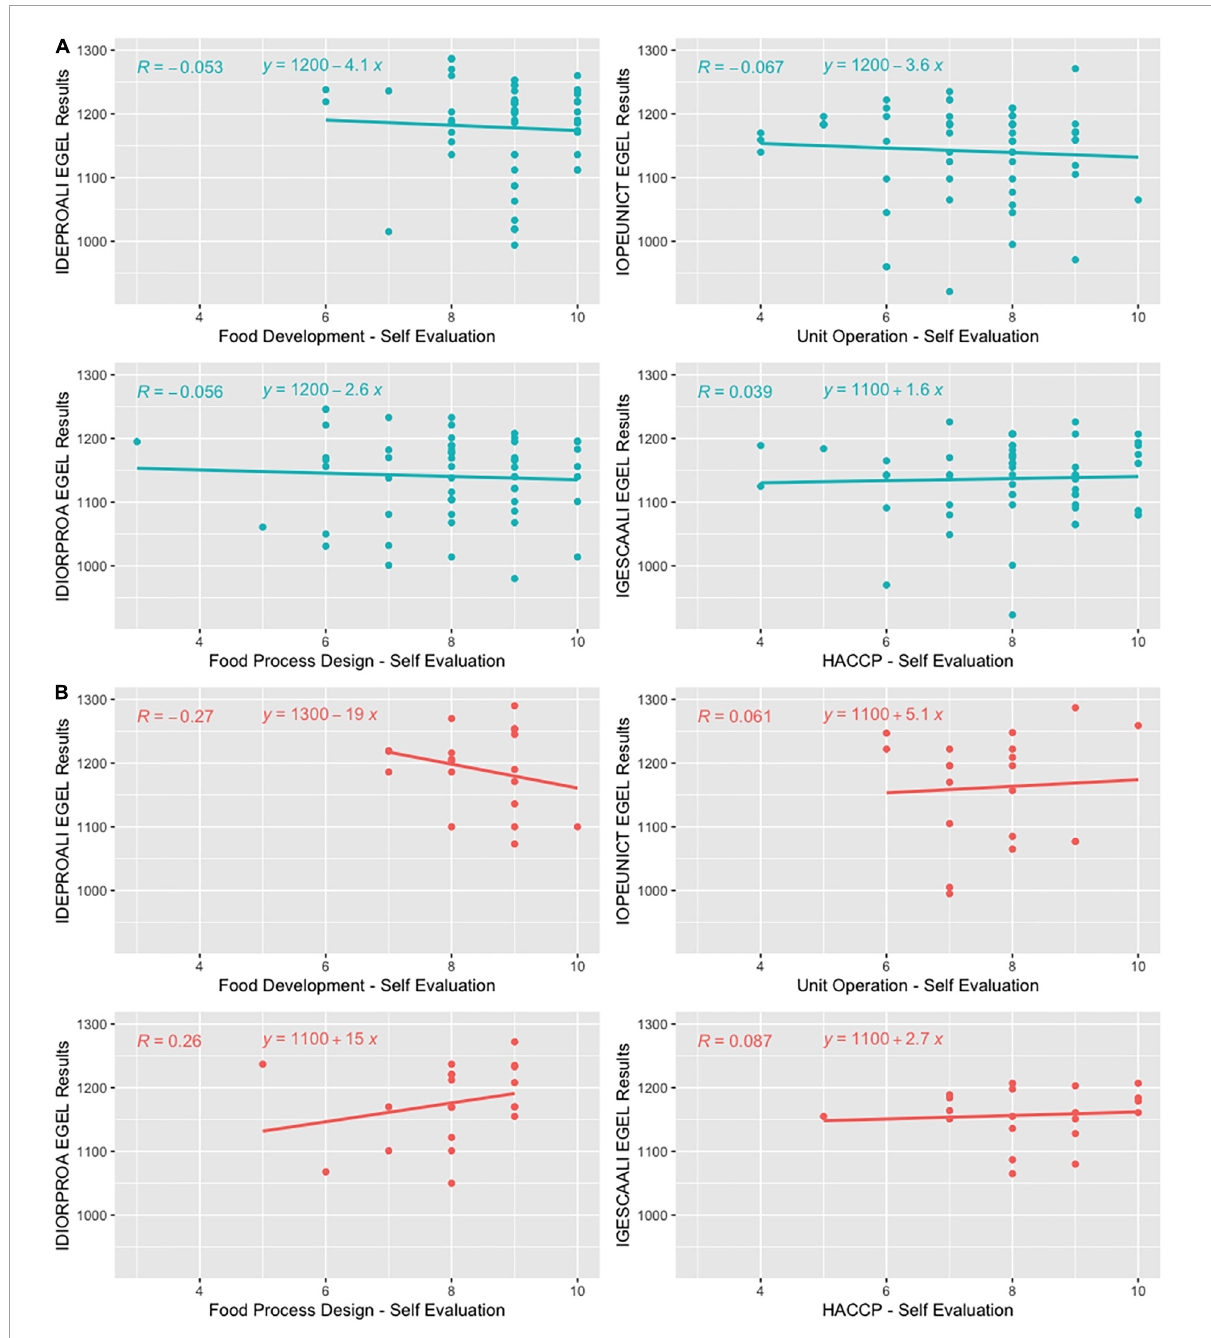
FIGURE9 EGEL (General graduation Exam by the National Centre of Evaluation) results and self-evaluation of academic categories mean results by EGEL section for (A) women and (B) men. IDEPROALI, Food Product Development; IOPEUNICT, Unit Operations for the Conservation or Transformation of Food; IDIORPROA, Design and Operation of Food Processes; IGESCAALI, Food Quality Management. The correlation coefficients for women by category were − 0.053, − 0.067, − 0.056, and 0.039, respectively; for men − 0.27, 0.061, 0.26, and 0.087,